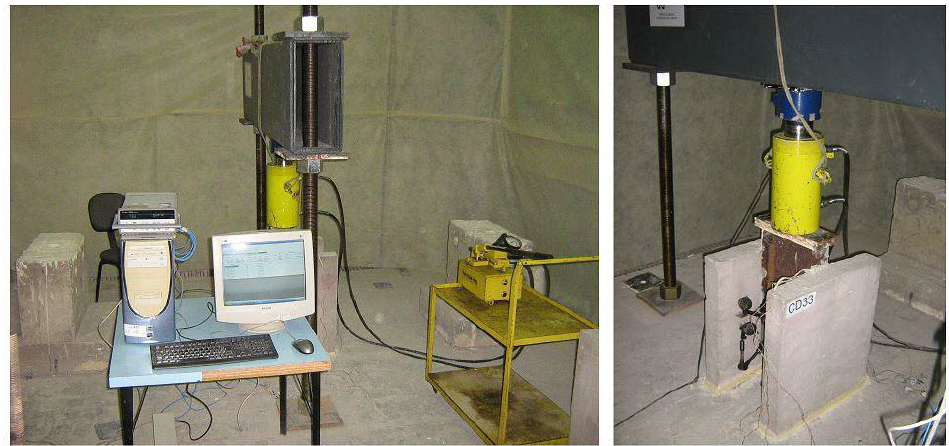
Figure 8. Test scheme for push-out.